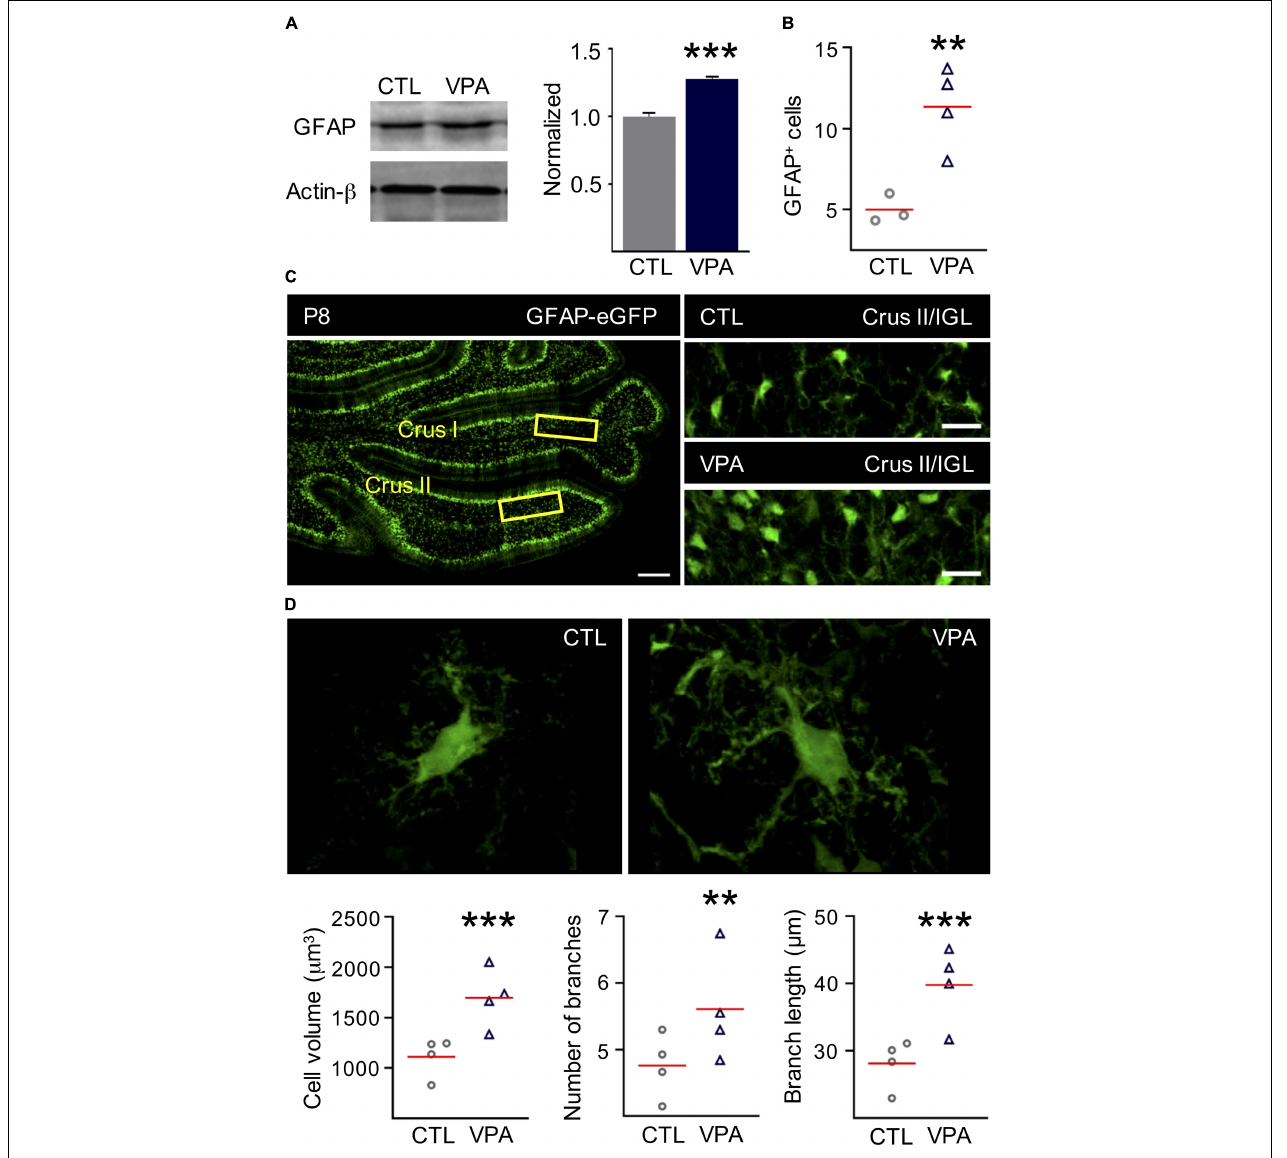
FIGURE 4 | GFAP expression, astrocyte density, and morphology complexity in the IGL are increased in the preclinical model of autism. (A) Representative Western blot showing the expression of GFAP protein (50 KDa) for CTL and VPA experimental groups. Actin- β (43 KDa) was used as internal control. The band intensities were normalized for CTL ( n = 16) and VPA ( n = 16) experimental groups (B,C) . The density of GFAP + cells is increased in the VPA model. Cell counting was performed in the cerebellar regions Crus I and Crus II of GFAP-eGFP transgenic mice (n CTL = 3, n VPA = 4). (C) Left, the horizontal section from the cerebellum shows Crus I and Crus II regions and the internal granular layer (IGL, yellow rectangles). Scale bar 100 µ m. Right, representative sections of IGL in Crus II showing GFAP + cell density CTL and VPA experimental groups. Scale bar 20 µ m. (D) Representative images and analysis of the astrocytic morphology showing an increase of the cell volume, number of branches, and branch length (426 cells in CTL, n CTL = 4; 445 cells in VPA, n VPA = 4, CTL = 4, n VPA = 4). Data analyzed by Shapiro–Wilk and Student’s t -test, ** p < 0.01, *** p < 0.0001. Values are mean ±